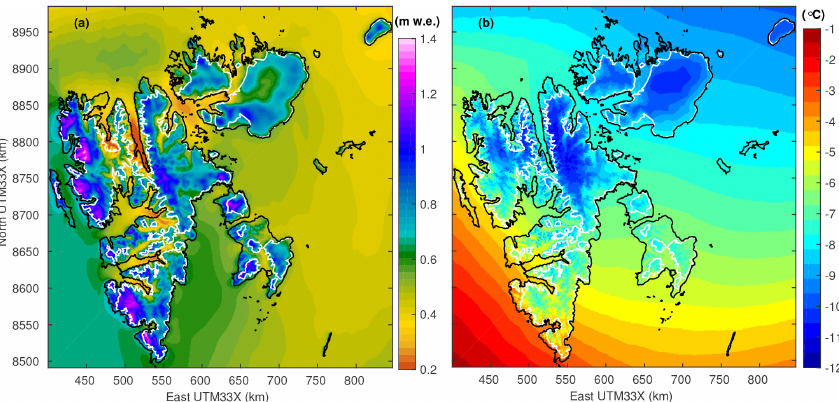
Figure 4. Downscaled annual precipitation (a) and annual mean 2m air temperature (b) averaged over the ERA-Interim period